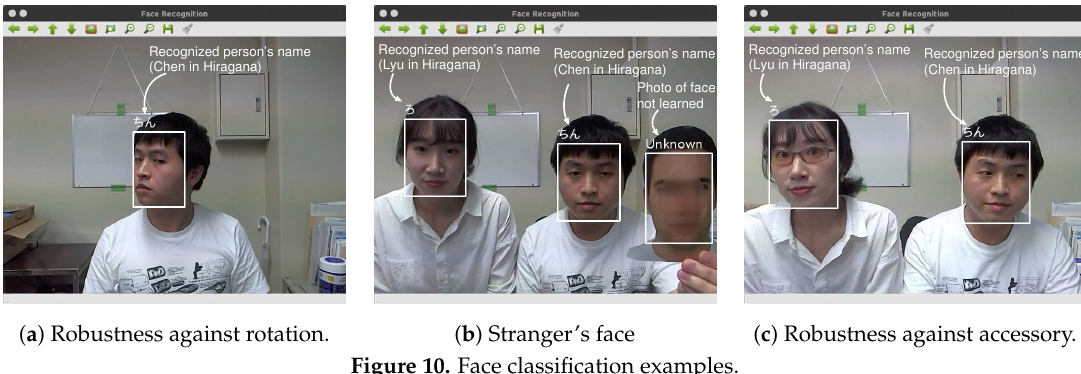
Figure 10. Face classification examples.